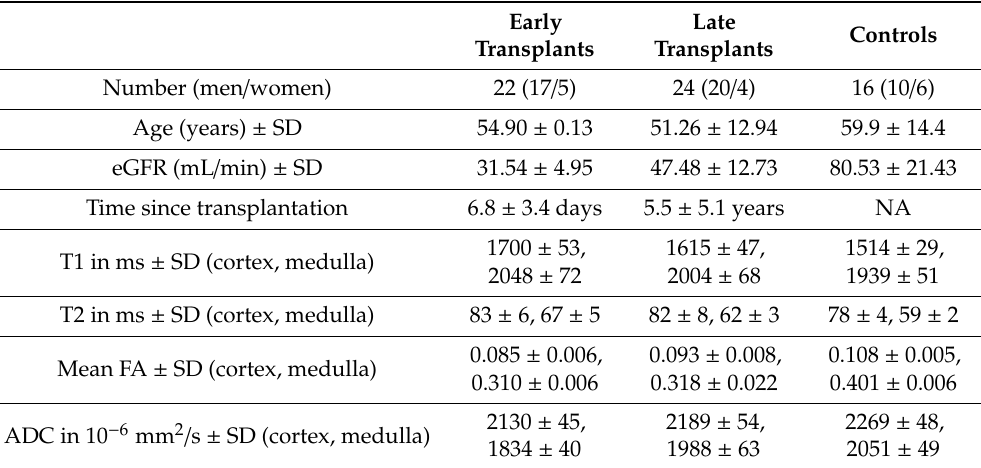
Table 2. Overview of study